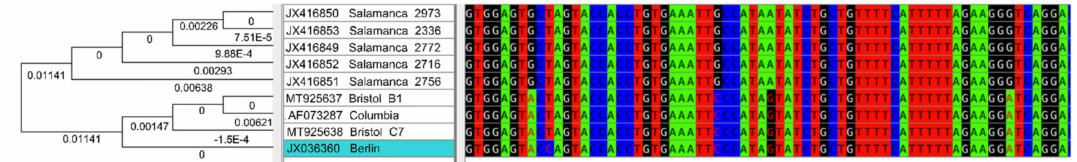
Figure 2. The nucleotide sequences of HaPyV strains from different Syrian hamster colonies available in GenBank were assembled and the contig formed with the phred-basecalling and the phrap-assembly tool available in the suite CodonCode Aligner v.9 (CodonCode Corp., Centerville, MA, USA). CodonCode Aligner also supported building neighbor-joining trees for the contig. The branch lengths of the neighbor-joining tree represent the distance between the samples. Part of the contig is shown on the right representing the area between nucleotides 3337 and 3404 of the Hamster polyomavirus isolate Berlin (GenBank JX036360). This area is located within the VP1